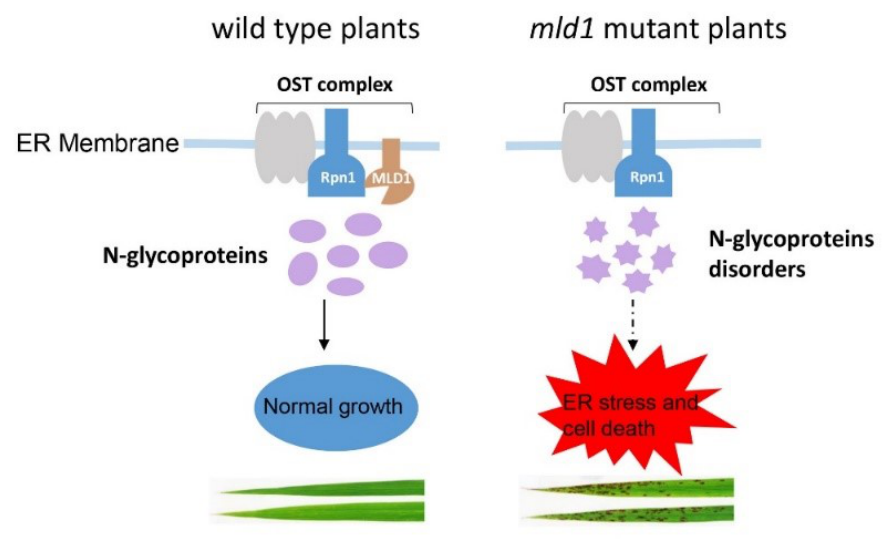
Figure 7. A proposed working model of the function of OsMLD1 in ER quality control. In the wildtype, OsMLD1 (malectin) forms a complex with ribophorin I (OsRpn1), which is one of the subunits of the OST complex. The interaction between OsMLD1 and OsRpn1 may account for the normal process of N -glycoproteins. In the mld1 mutant, the disruption of OsMLD1 disturbs the association with N -glycoproteins, resulting in the normal modification of glycoproteins to be affected, which leads to prolonged ER stress in the mld1 plants.